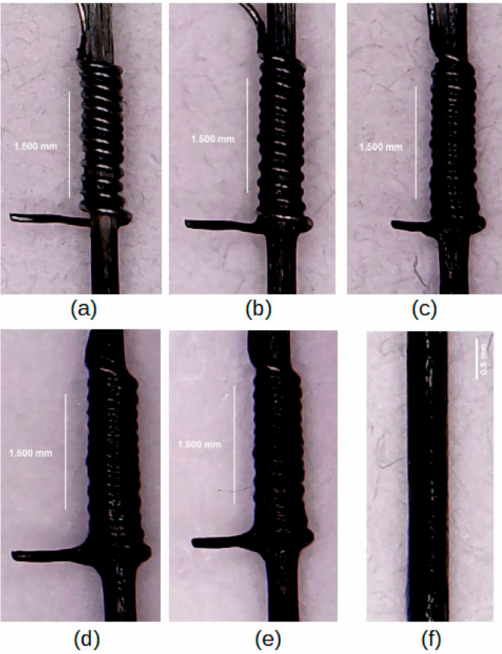
Figure 7. Pictures of connector for 1 ( a ), 2 ( b ), 4 ( c ), 6 ( d ), and 8 ( e ) layers of Clevios TM F020 and sensor zone located between two connectors with 8 layers of Clevios TM F020 ( f ) obtained by using optical microscope.